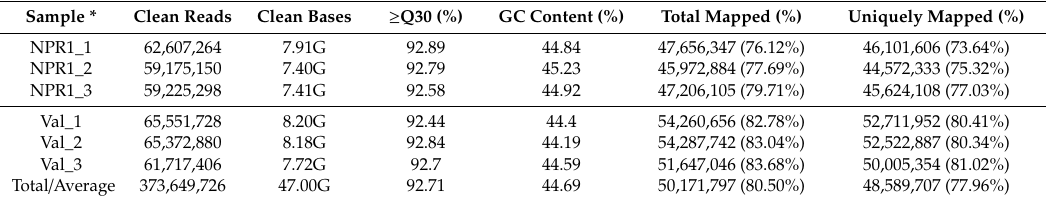
Table 1. Summary of sequencing data from the di ff erent replicates of the NPR1-2 transgenic line and control non-transgenic ‘Valencia’ line.